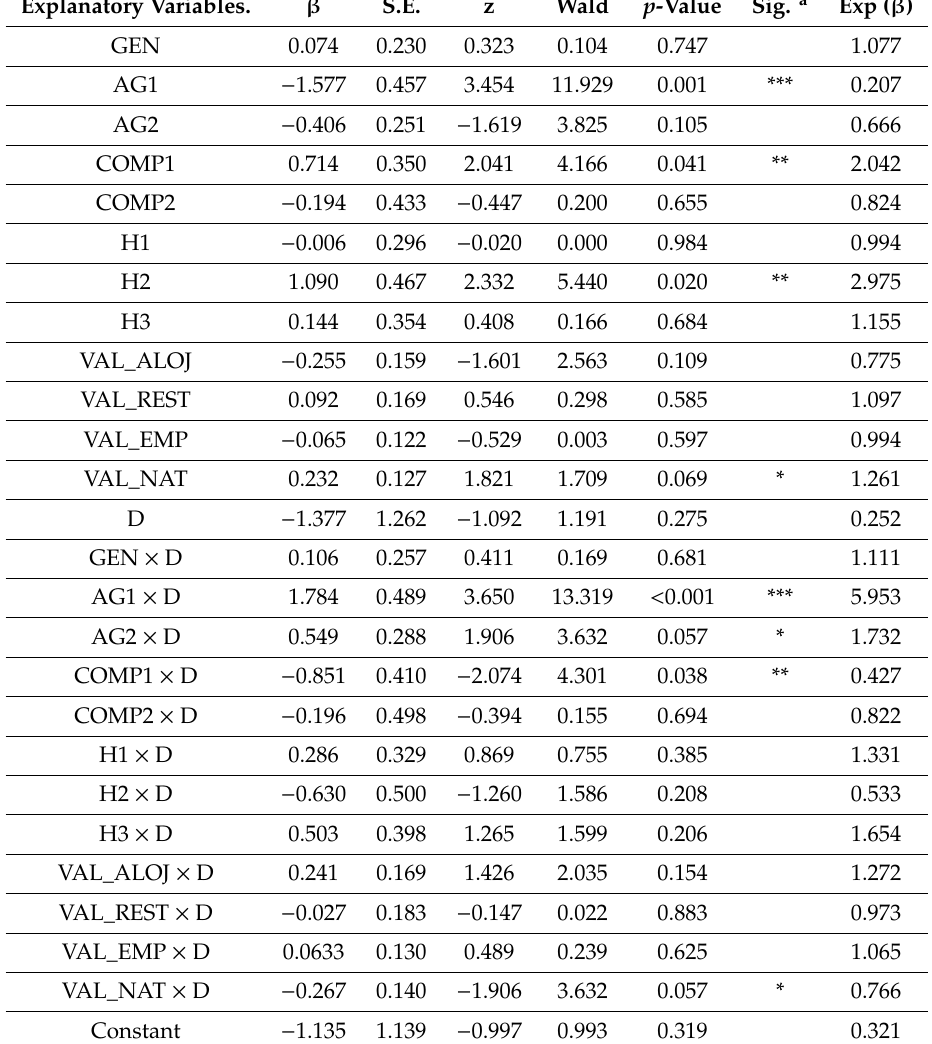
Table 2. Estimation of the binary logistic regression model (2). Non-restricted model. Explanatory